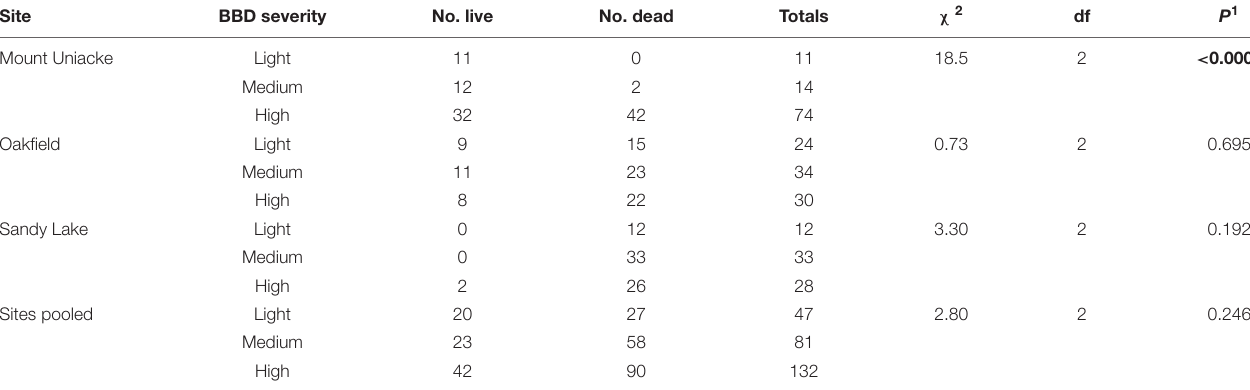
Data for percentage tree mortality from all three sites, 2016–2019; data for leaf mines and adult feeding from Oakfield and Mount Uniacke, 2016–2019, because no foliage was available at Sandy Lake due to excessive tree mortality. All percentage data were transformed by arcsine square root and did not depart significantly from normality (Shapiro Wilks, P > 0.35). TABLE 3 | Numbers of live and dead American beech in 2019 in each of three categories of beech bark disease (BBD) severity at three sites in Nova Scotia, Canada. Site No. live